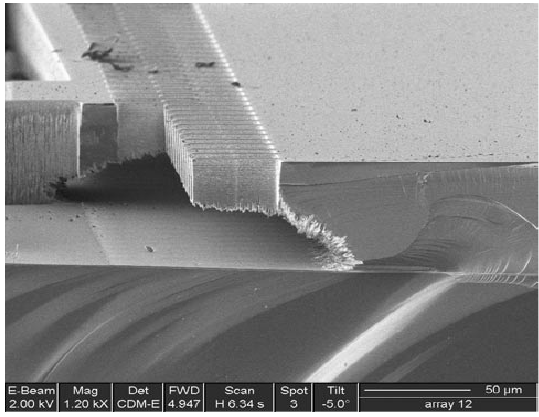
Figure 6. SEM images of footing effect for unexpected DRIE process results.